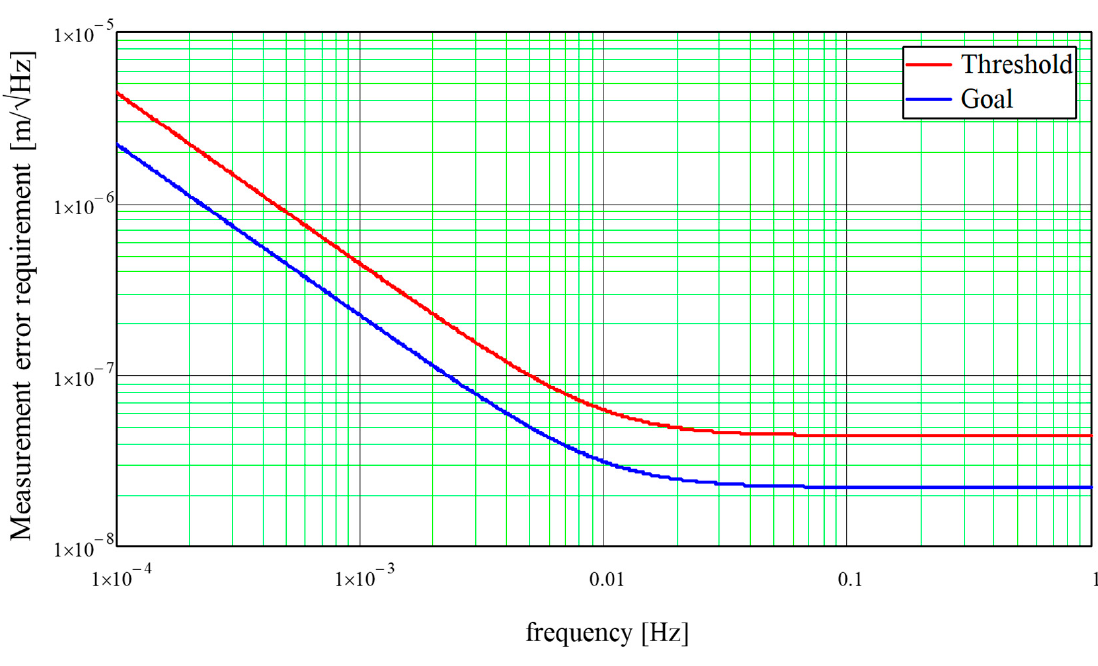
Figure 3. Requirements (threshold and goal) on the stochastic measurement error of Δ d.